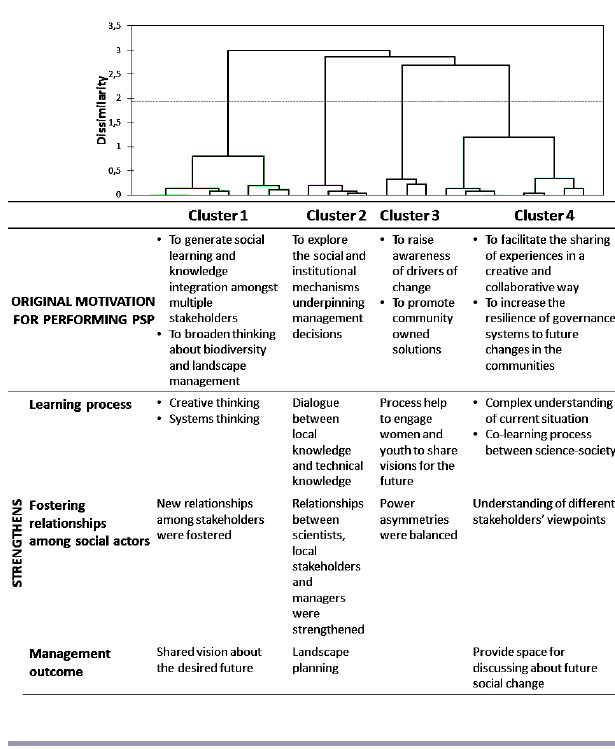
Fig. 6 . Clusters resulting from hierarchical cluster analysis and the related motivation for the participatory scenario planning process and the strengths identified in each group of case